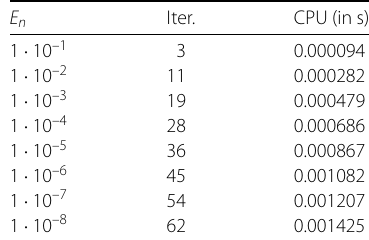
Table 2 Numerical results of Algorithm